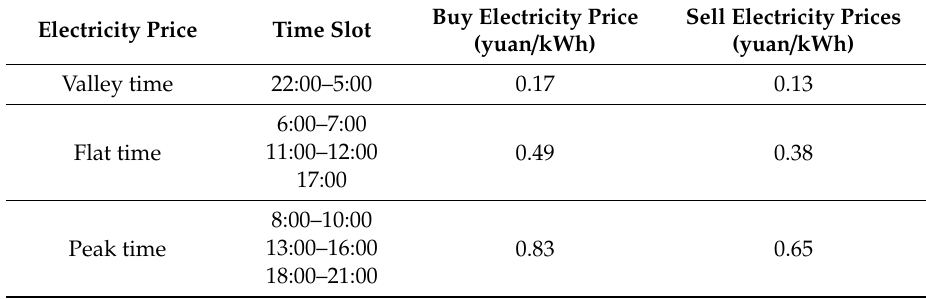
Table 4. Time-of-use tari ff .